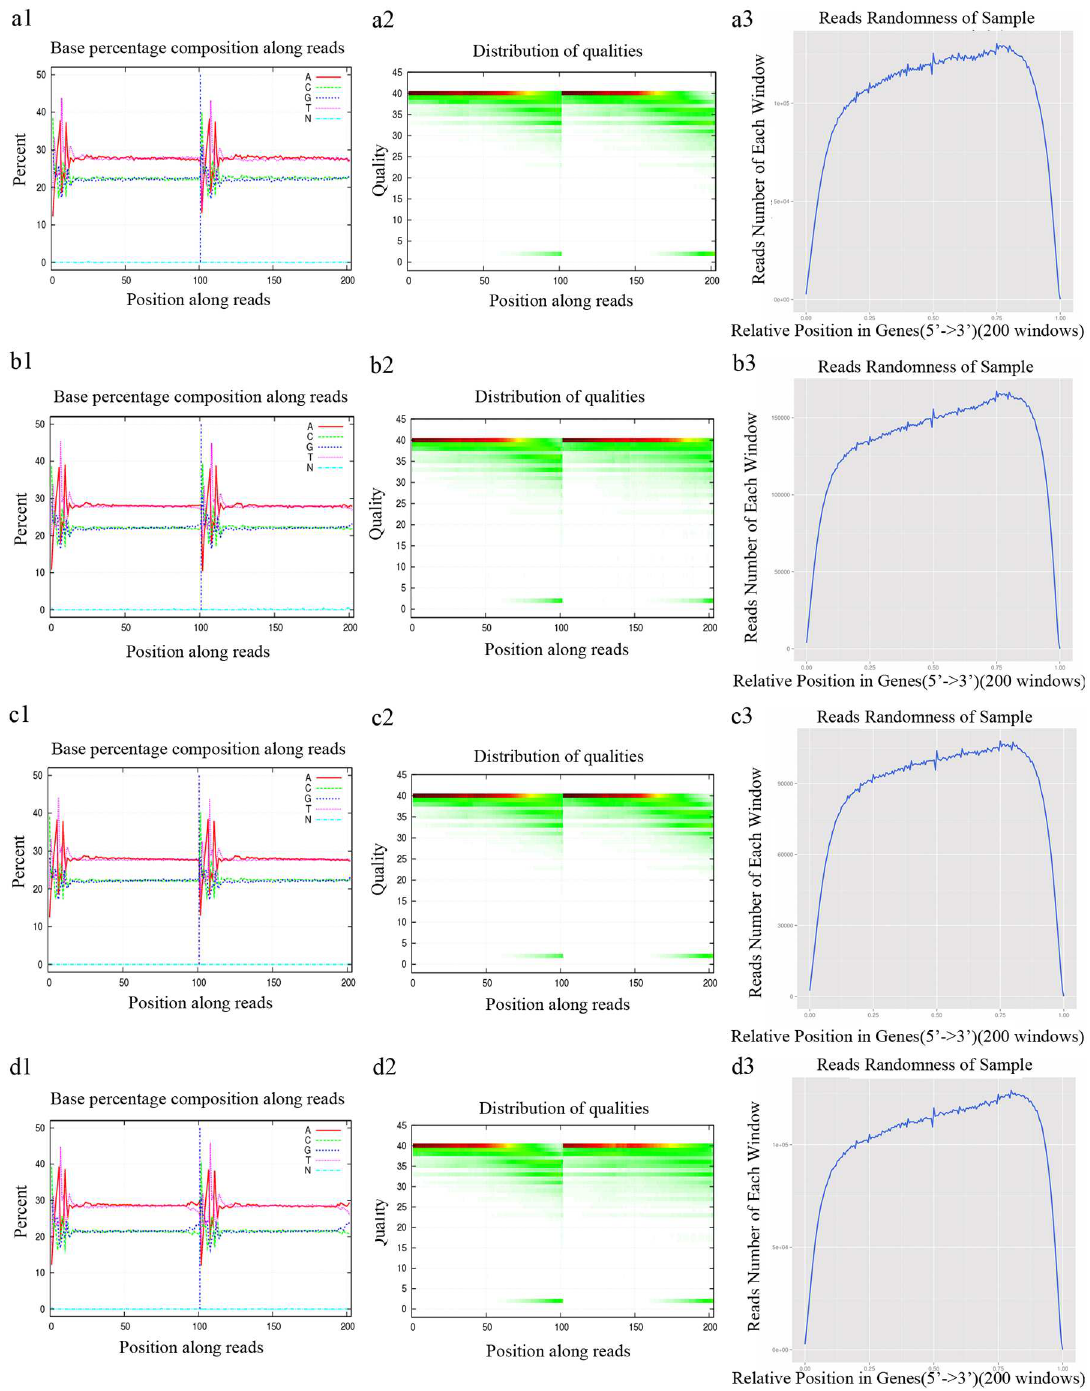
Fig 2. Sequencing data assessment. Base composition of clean data in PT2 (a1), PT2S (b1), PT (c1), and PT4S (d1); base quality of clean data in PT2 (a2), PT2S (b2), PT4 (c2), and PT4S (d2); reads distributionon PT2 (a3), PT2S (b3), PT4 (c3), and PT4S (d3)